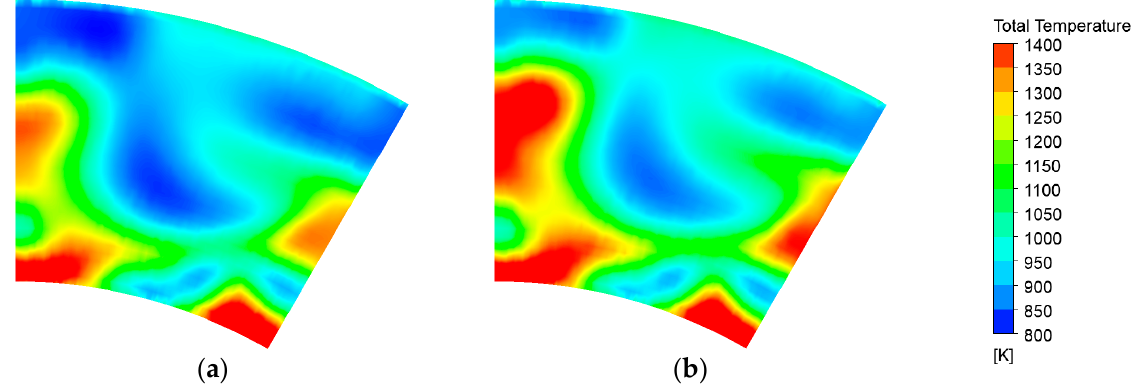
Figure 10. Combustor outlet total temperature contour with: ( a ) uniform outlet; ( b ) non-uniform outlet pressure boundary condition.